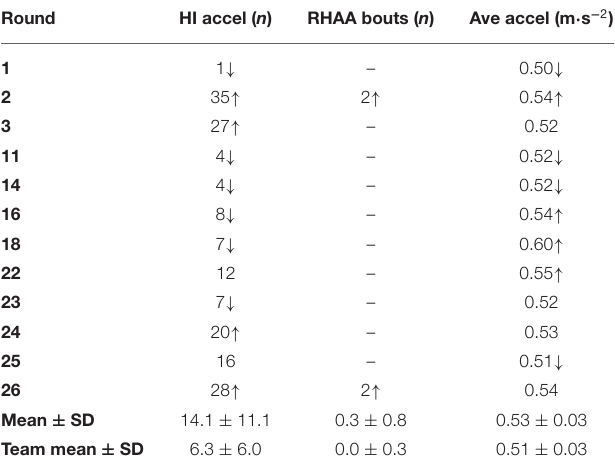
TABLE 1 | The number of high-intensity accelerations, RHAA bouts, and average acceleration (m · s − 2 ) in competitive matches for an elite youth footballer across his entire season (12 matches from 27